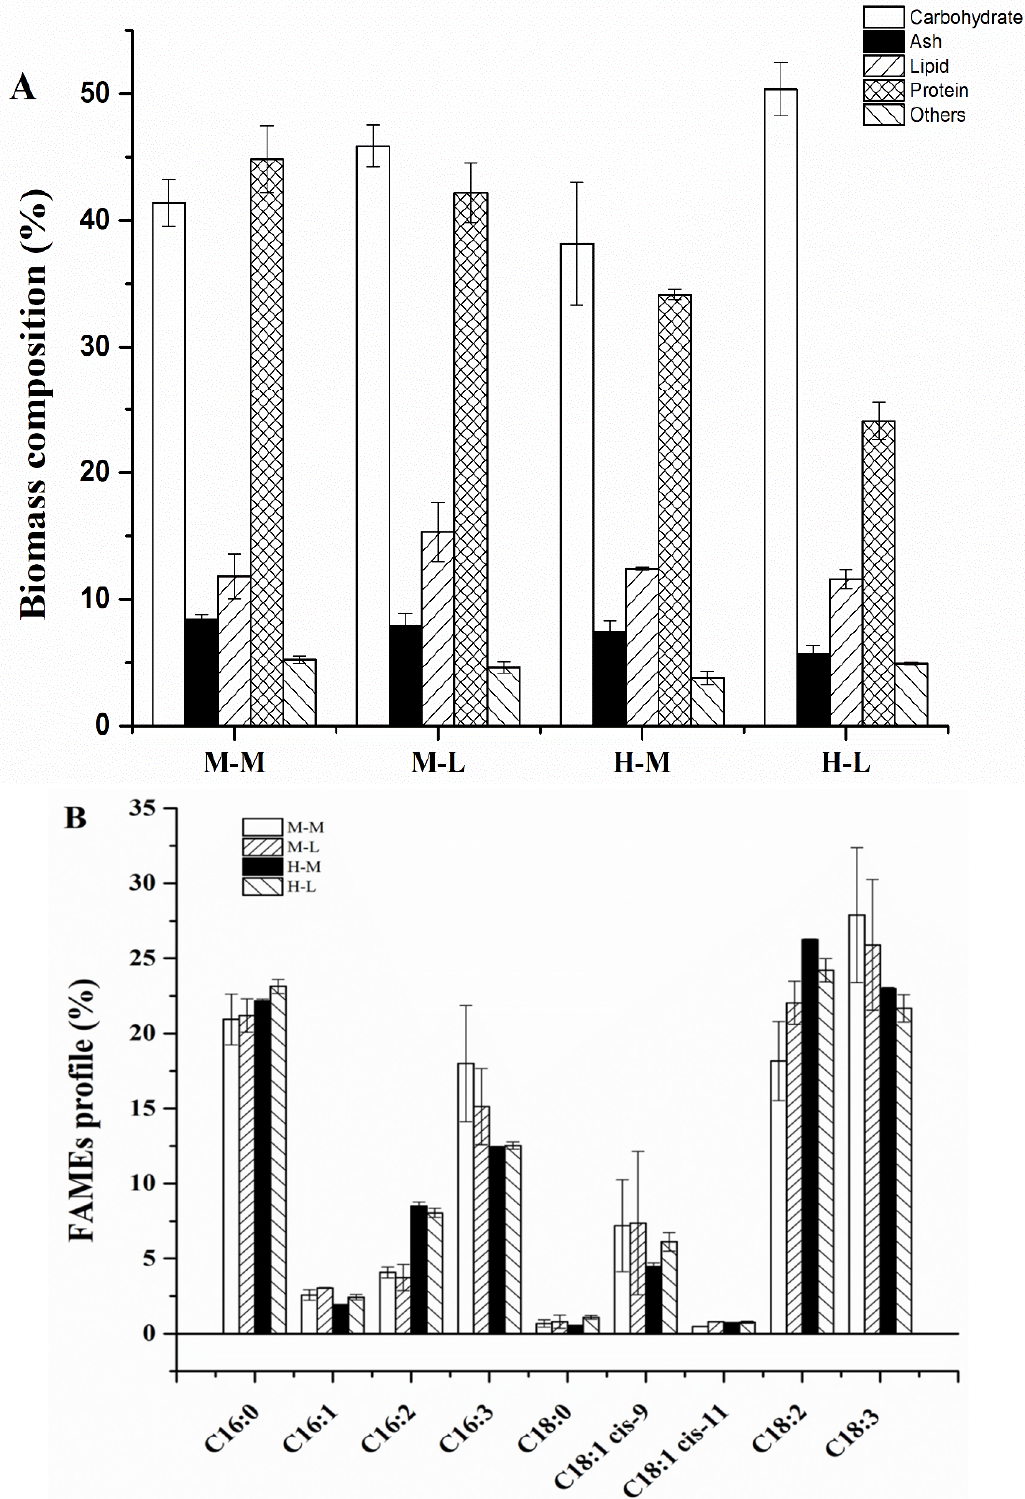
Figure 2. The biomass composition and FAMEs profile of C. sorokiniana when cultured mixotrophically and heterotrophically. ( A ) Biomass composition; ( B ) FAMEs profile. M-M, mid-exponential phase in mixotrophy; M-L, late exponential phase in mixotrophy; H-M, mid-exponential phase in heterotrophy; H-L, late exponential phase in heterotrophy.